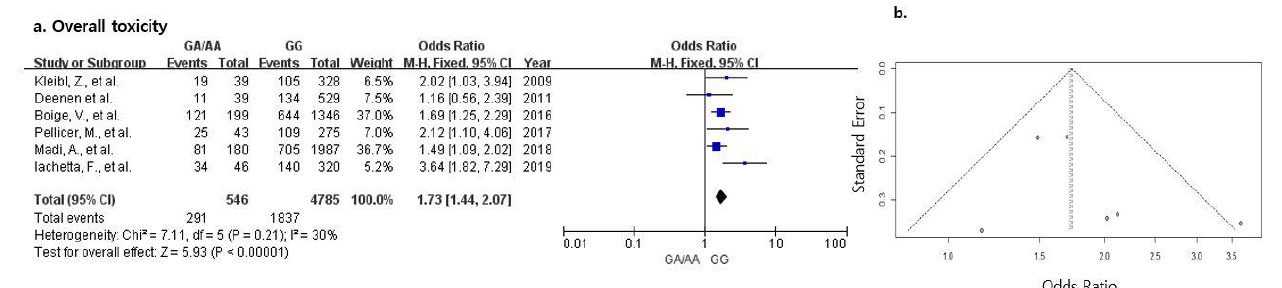
Figure 2. ( a ). Forest plot of the association between fluoropyrimidine-induced overall toxicity and DPYD polymorphism ( b ). Funnel plot of fluoropyrimidine-induced overall toxicity and DPYD polymorphism. Table 2. Sensitivity analysis by sequentially excluding each study from the